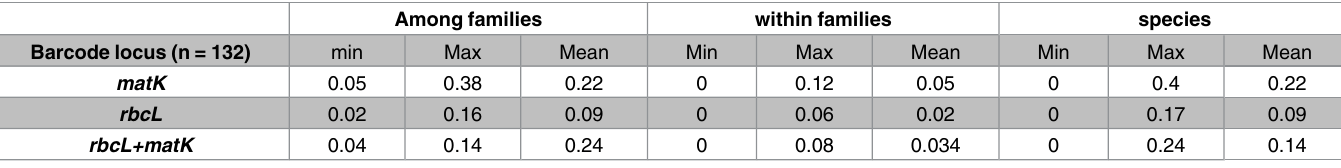
0.22, 0.05 and 0.22; respectively (Table 3). In rbcL mean distance among families, within fami- lies and among species were 0.09, 0.02 and 0.09; respectively. rbcL+matK showed the largest distances compared to individual locus. However, minimum distances among families in indi- vidual or combined loci were higher than minimum within families or among species. Nucleotide diversity, number of segregation sites and number of haplotypes for the two bar- code loci for all genera represented by several species were calculated (Fig 2). The number of species ranged from 1 ( Hibiscus rosa-sinensis L.) in matK and rbcL to 5 in rbcL such as in the genus Kalanchoe ( K . beharensis Drake, K . blossfeldiana Poelln., K. manginii Raym.-Hamet & H.Perrier, K . thysiflora Balfour and K . tomentosa Golden Girl) as shown in Fig 2 and in S1 Table. The highest number of segregation sites in all genera was in Pilea between P . cadierei Gagnep. & Guillaumin and P . serpyllacea (Kunth) Liebm. The Pilea was followed by Salvia cul- tivars and Justicia cultivars for matK . The nucleotide diversity ratio followed the same trend as for the segregation sites where the highest value was in the Pilea followed by Salvia ( S . splen- dens Sellow ex Schult. & S . virdis L.) and Justicia (J. adhatoda L. & J . brandegeeana Wassh. & L. B.Sm.) in both loci. In matK , the number of haplotypes ranged from 1–4 (Fig 2). Nucleotide diversity was highest in Pilea (12.9%) followed by Salvia (6.5%) and Justicia (4.3%) whereas the remaining genera ranged from 2–0%. In rbcL , the number of haplotypes was either high (5, 4 and 3) such as in Kalanchoe , Dracaena and Narcissus L., respectively or low (2 or 1) in all remaining genera. The highest values were found in Pilea (3.08), Chrysanthemum L. (1.45), Narcissus (0.97), Justicia (0.72) and Dracaena (0.36). Table 3. Genetic distances in barcode loci at three taxonomic levels. Among families within families